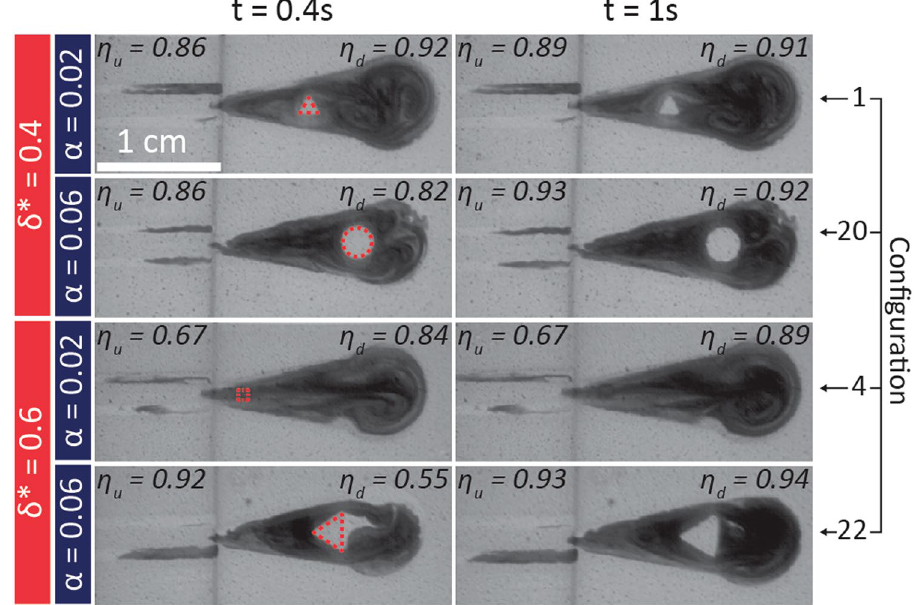
Figure 4. Images of transient mixing patterns near superhydrophobic islands for four select SDSM configurations. For t = 0.4 s (left column), high and low values of the area ratio ( α ) and constriction ratio ( δ * ) are shown to have profound effects on the mixing efficiency 500 μ m upstream ( η u ) and 500 μ m downstream ( η d ) of the island. Islands having small α (e.g., configurations 1 and 4) demonstrate more efficient mixing downstream of the island (i.e. η d > η u ). On the other hand, islands having high α (e.g., configurations 20 and 22) demonstrate more efficient mixing upstream of the island (i.e. η u > η d ). For t = 1 s (right column), homogeneous mixing is more evident, where similar upstream and downstream mixing efficiencies are demonstrated. Superhydrophobic islands are outlined with a red dashed line in each t = 0.4 s image for visualization